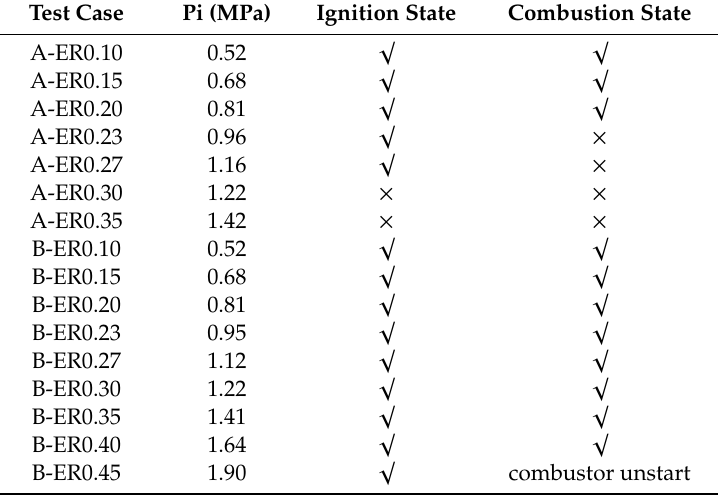
Table 2. Experimental